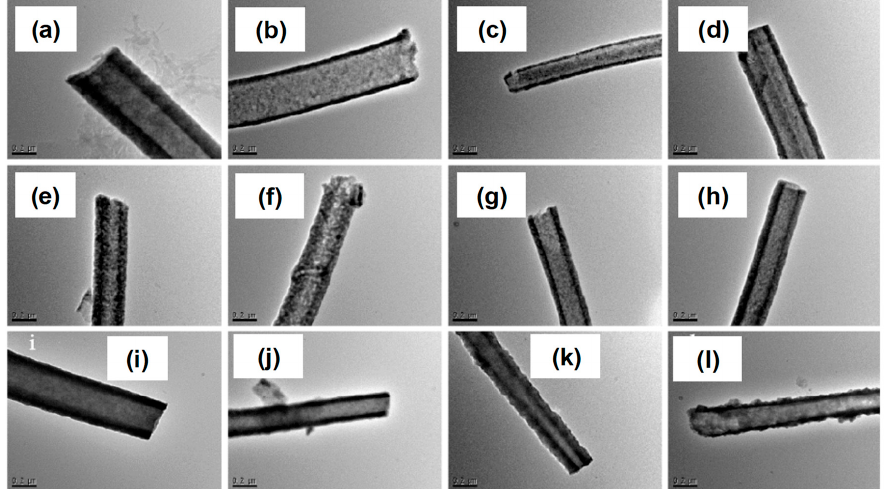
Figure 10. TEM images of metal oxide/TiO 2 hybrid nanotubes ( a – d : Zr, e – h : Nb, and i – l : Si). Ti:Zr = 9:1 ( a ); 8:2 ( b ); 7:3 ( c ) and 6:4 ( d ); Ti:Nb = 9:1 ( e ), 8:2 ( g ) and 6:4 ( h ); Ti:Si = 9:1 ( i ), 8:2 ( j ), 7:3 ( k ) and 6:4 ( l ). Scale bars are 0.2 µ m. Reproduced from Reference